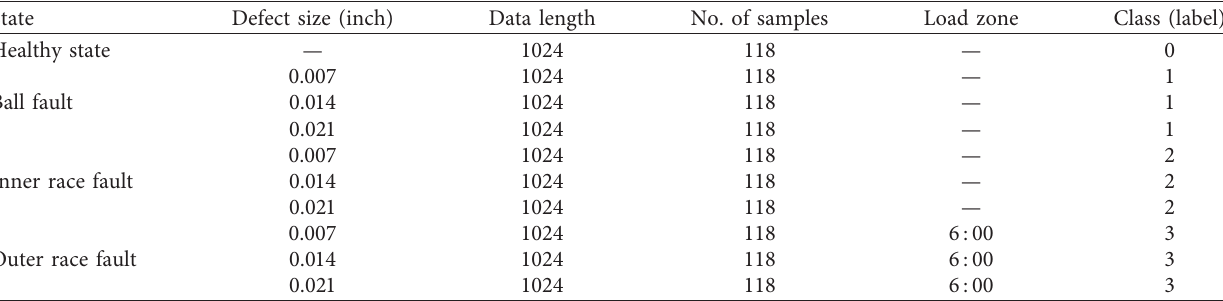
Table 1: CWRU experimental